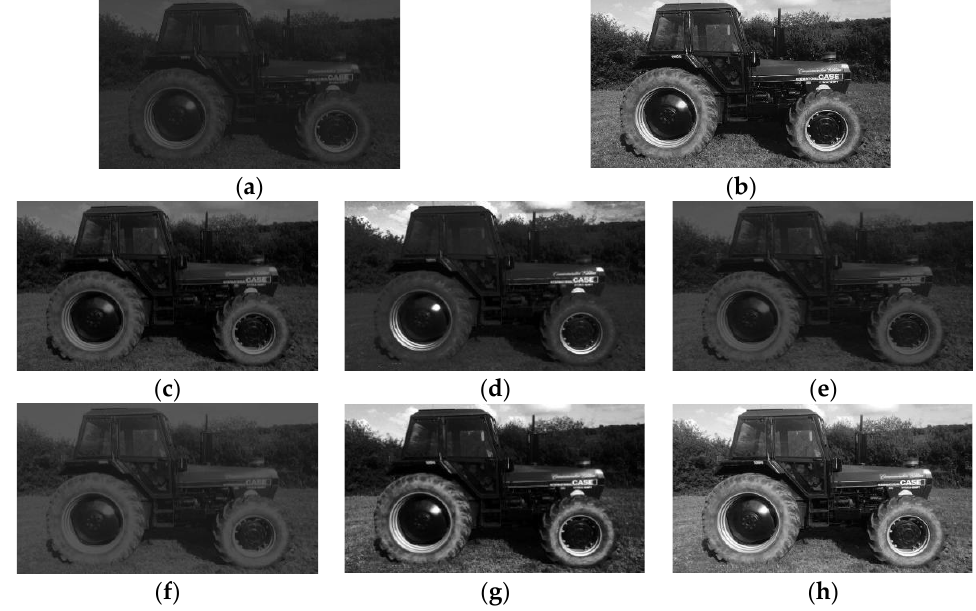
Figure 9. Image named “Tractor” enhanced with several algorithms: ( a ) original image, “Tractor”; ( b ) Ref. [30]; ( c ) BHEMHE; ( d ) RMSHE; ( e ) DSIHE; ( f ) AGCWD; ( g ) BHEPL; ( h ) proposed